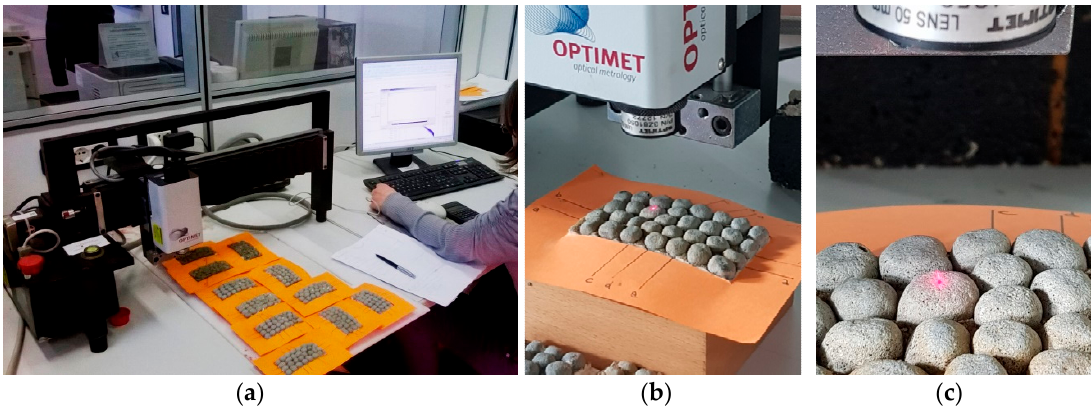
Figure 11. ( a , b ) Laser profilometer based on conoscopic holography used in the experimentation and ( c ) detail of the laser beam incidence on the surface of the granules.